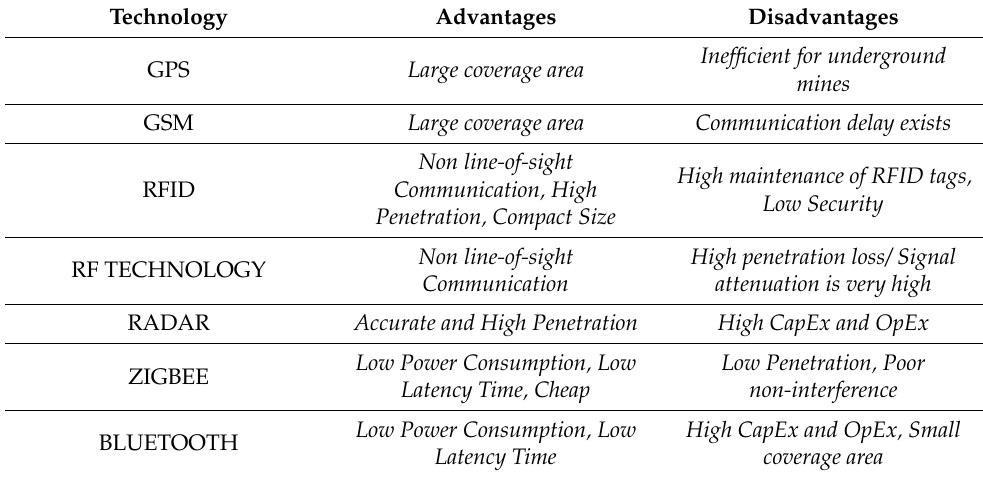
Inefficient for